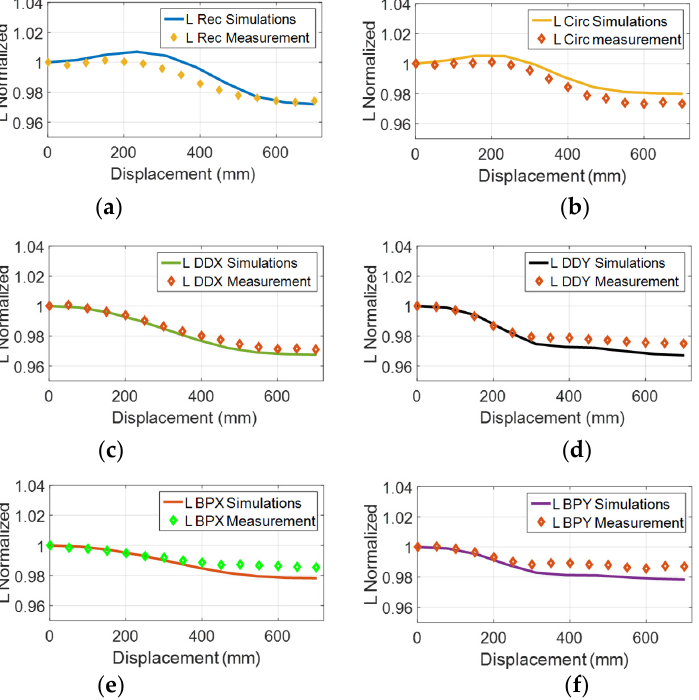
Figure 22. Measurement of normalized self-inductance compared to simulation results. ( a ) rectangular; ( b ) circular; ( c ) DDX; ( d ) DDY; ( e ) BPX; ( f ) BPY.